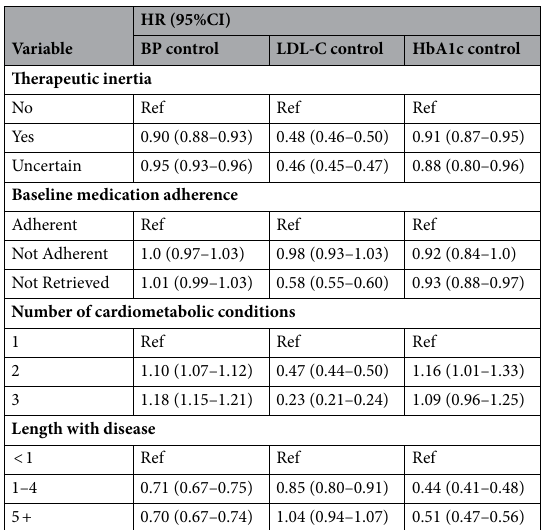
Table 3. Hazard Ratio estimate from Cox regression models for each biometric measure during 5 years of follow-up* *In addition to above variables, we further controlled additional baseline characteristics, including age groups, gender, race/ethnicity, body mass index (BMI), Charlson comorbidity index (CCI), smoking status, alcohol status, insurance, number of office visits between 10/1/2015–9/30/2017, and corresponding baseline biometric value.